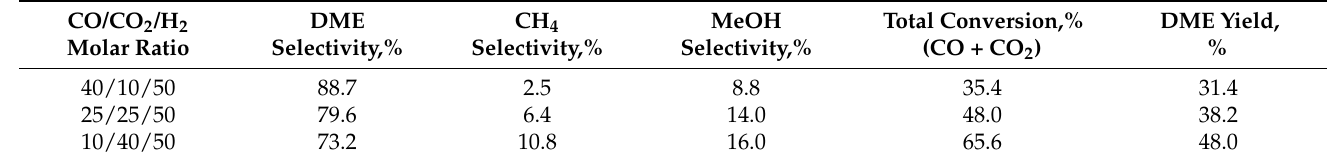
Table 6. Conversion and product distribution of 25STA@CZA-MA catalysts for DME synthesis